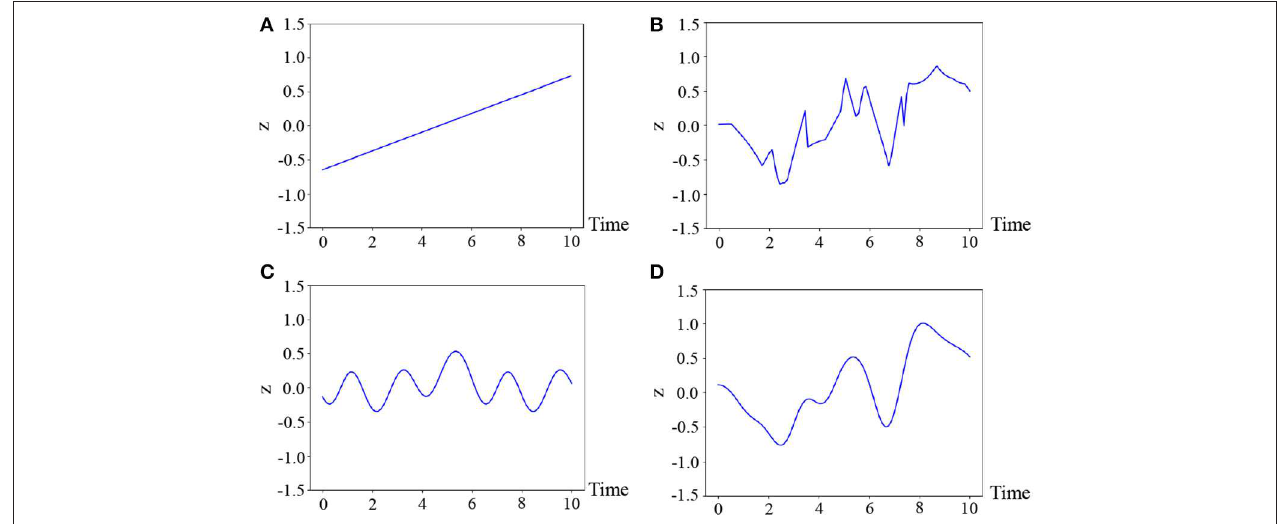
FIGURE 4 | Four temporal patterns sampled from the Gaussian processes, where (A) linear : i p i q , (B) exponential : exp( −| i p − i q | ), (C) periodic : exp(cos | i p − i q | ), and (D) RBF : exp( −| i p − i q | 2 ) are used.